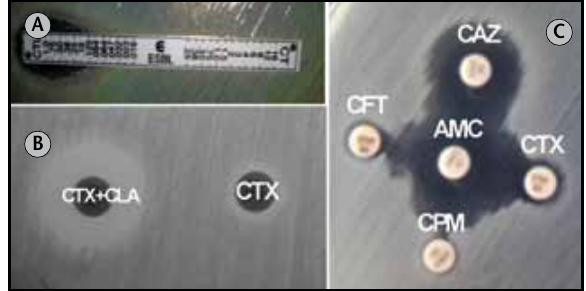
Figura 2 – Testes fenotípicos para identificação de